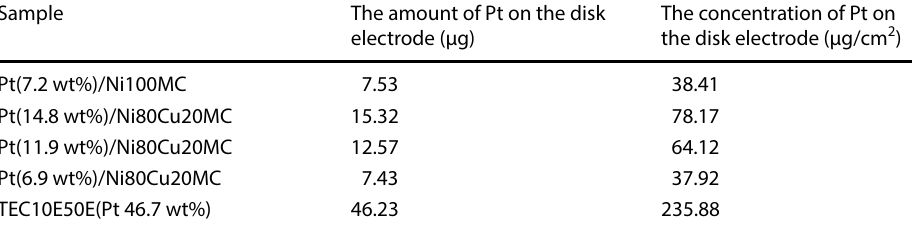
Table 2 The amount of Pt on the disk electrode used for the RRDE mesurements